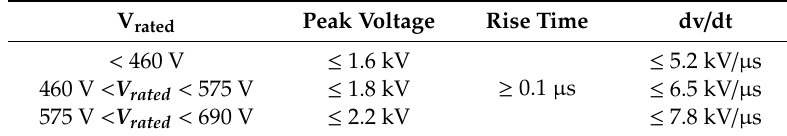
Figure 2. System configuration of GaN-based VFD with sine wave filter. Table 2. IEC Standards for motor voltage